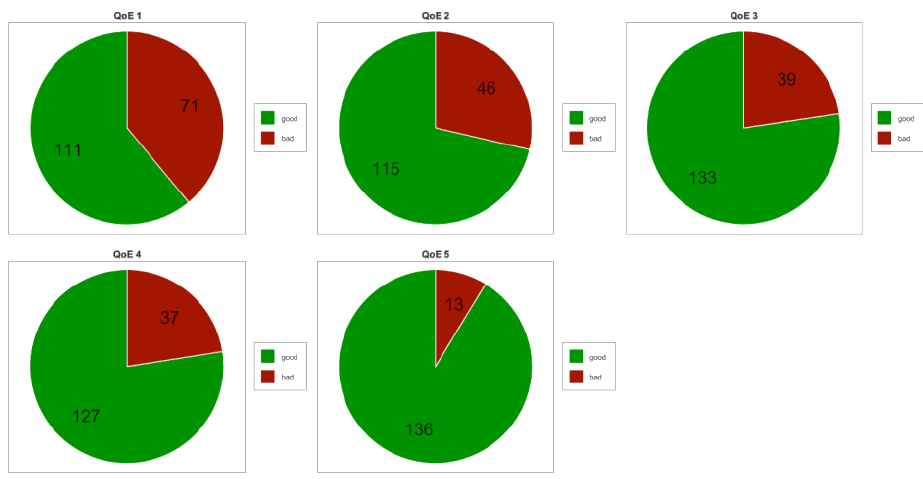
Figure 6. Distribution of the services quality and assessments in the network.